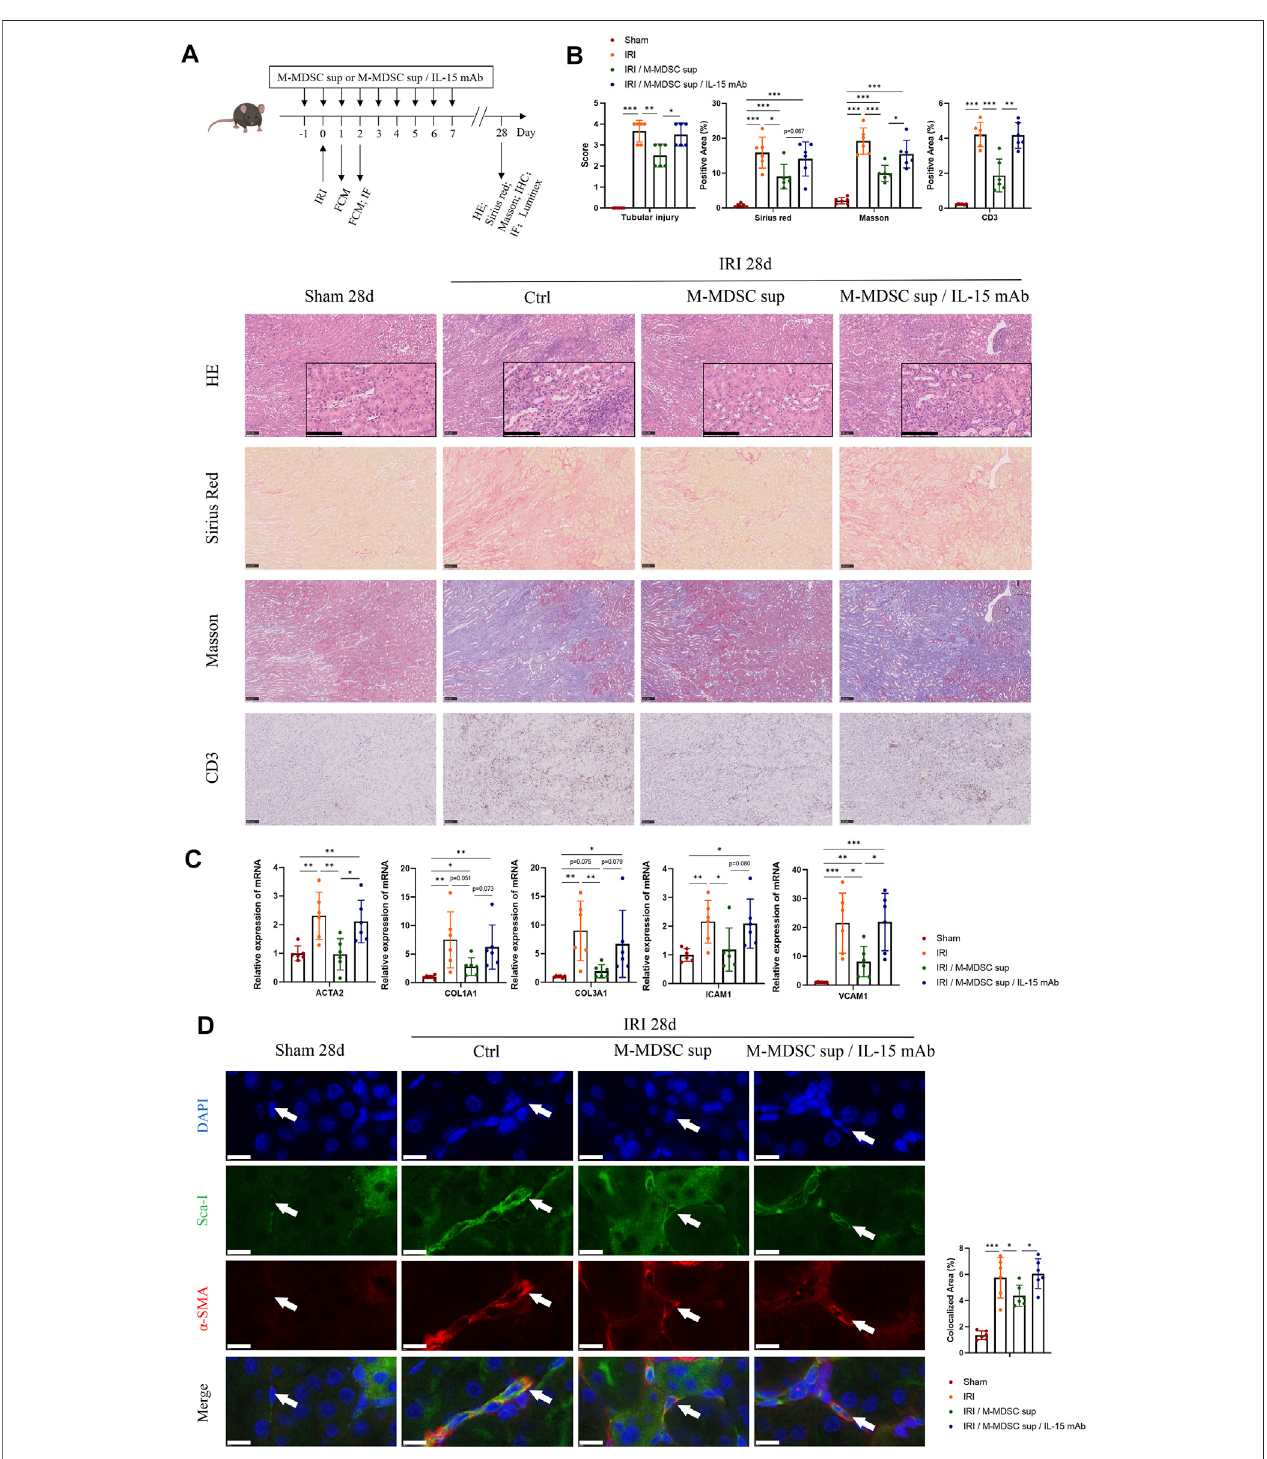
FIGURE 5 | Treatment with M-MDSC supernatant ameliorates renal fi brosis and myo fi broblastic differentiation in RRMSCs. (A) M-MDSC supernatant or M-MDSC supernatant/IL-15 mAb wasadministered toC57BL/6mice1day prior to theIRI operation and for seven consecutivedaysaftertheIRIoperation.Thebonemarrow and spleen wereharvestedonDays1and2,andkidneyswereharvestedonDays1,2and28aftertheoperation. (B) OnDay28aftertheoperation,tubularinjurywasmeasuredbyH&E,while renal fi brosiswasmeasuredbySiriusRedandMassontrichromestaining.TheexpressionofCD3wasmeasuredbyimmunohistochemistry.Scalebar:100 μ m. (C) OnDay 28aftertheoperation,themRNAexpressionofACTA2,COL1A1,COL3A1,ICAM1andVCAM1inrenaltissueswasnormalizedtoGAPDHexpression.Valueswereexpressedas mean ± standarddeviation(mean ± SD). (D) Immuno fl uorescencecostainingofSca-1/ α -SMAinthekidneyonDay28aftertheoperation.Averagedataforareaofco-stainedSca- 1 + α -SMA + renal resident MSCs were quanti fi ed. Values were expressed as mean ± standard deviation (mean ± SD). Scale bar: 10 μ m. IHC: Immunohistochemistry; FCM: Flow cytometry; IF: Immuno fl uorescence staining. * p < 0.05; ** p < 0.01; *** p < 0.001.